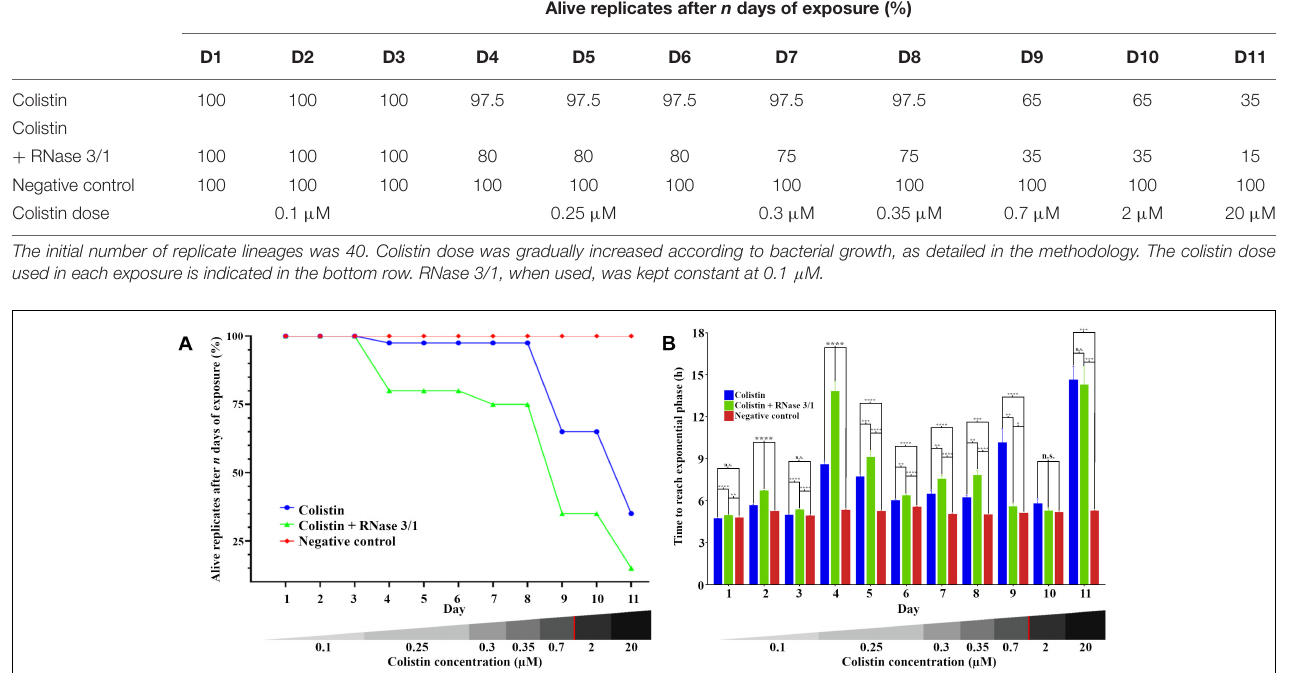
TABLE 4 | Evolution of the resistance acquisition of A. baumannii to colistin, considering the number of replicates alive after each day of exposure. Alive replicates after n days of exposure (%)